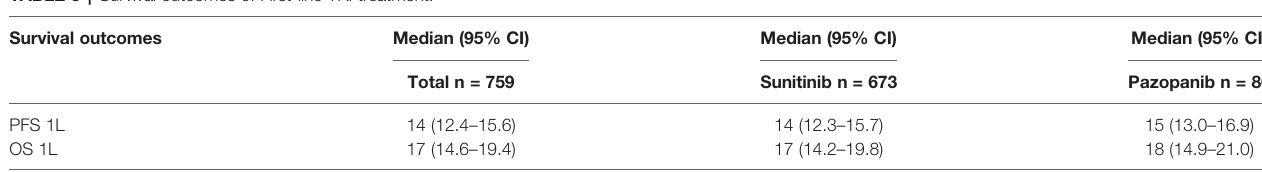
TABLE 3 | Survival outcomes of First-line TKI treatment. Survival outcomes